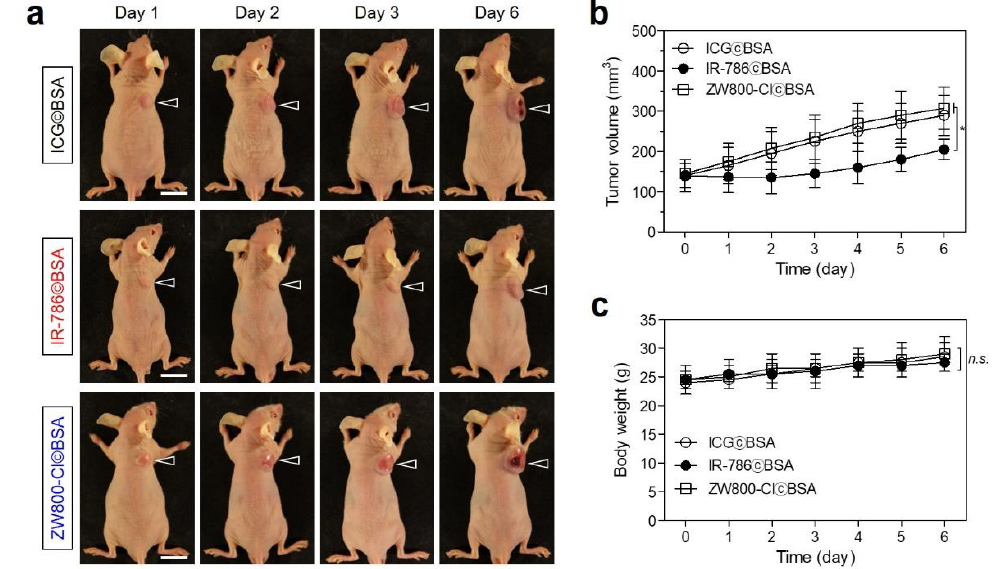
Figure 6. In vivo chemotherapeutic efficacy. ( a ) Representative photos of tumor size changes in HT-29 tumor-bearing mice for 6 days after different treatments. The tumor sites are indicated by arrowheads. Scale bars = 1 cm. ( b ) Tumor growth rates and ( c ) body weights of each treatment group were monitored for 6 days. Images are representative of 3 mice per treatment group. Data are expressed as mean ± S.D. ( n = 3, * p < 0.05; n.s. = not significant).